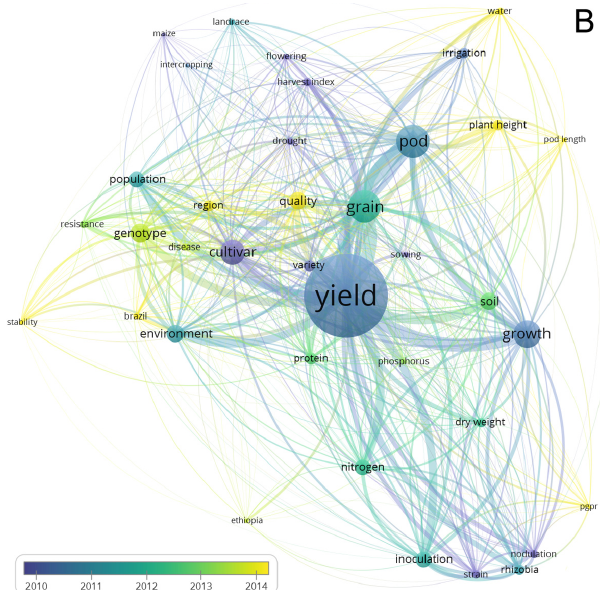
Figure 6. Concept network map produced by VOSviewer for terms counted more than 10 times in the titles and/or abstracts across the 228 publications, which were included in the systematic review. The size of the circle indicates the frequency of the term appearance. The connection of the terms with a line shows co-occurrence. Thin lines indicate low co-occurrence while thick lines indicate high co-occurrence of the interconnected terms. ( A ) Network visualization of terms co-occurrence coloured by co-occurrence and ( B ) thematic evolution of terms in the field of research on agronomic practices that increase yield and quality of common bean, coloured by year.